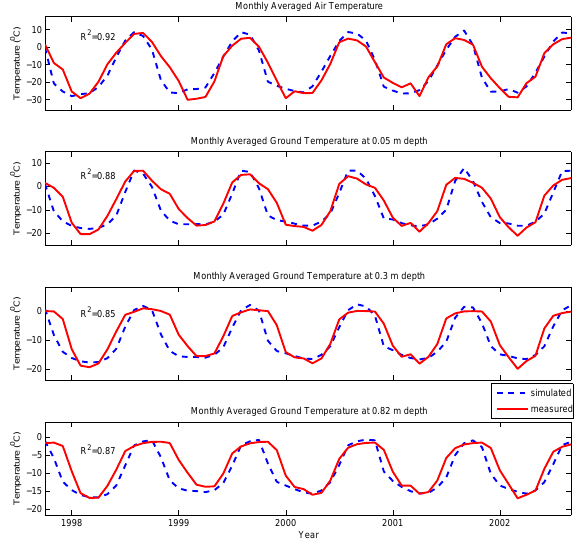
Fig. 2. Measured (solid) and calculated (dashed) monthly averaged temperatures at 2m above the ground and 0.05, 0.3 and 0.82m depth for WestDock 70.37 ◦ N, − 148.55 ◦ W permafrost observa- tion station.